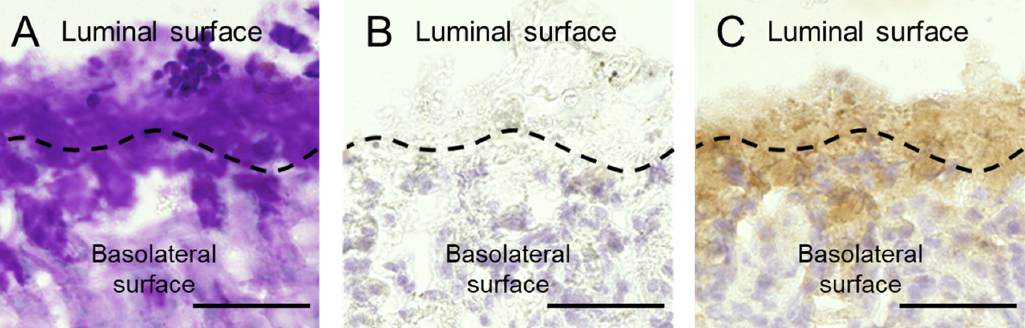
Figure 6. Distribution of Gal-2 in gastric mucus. ( A ) Periodic acid-Schiff (PAS) staining. ( B ) Isotype control. ( C ) Anti-mouse Gal-2 antibody. Upper and lower parts of these images are the luminal side and basolateral surface, respectively. The black dotted lines indicate gastric mucosal surface. Scale bars represent 50 µm.